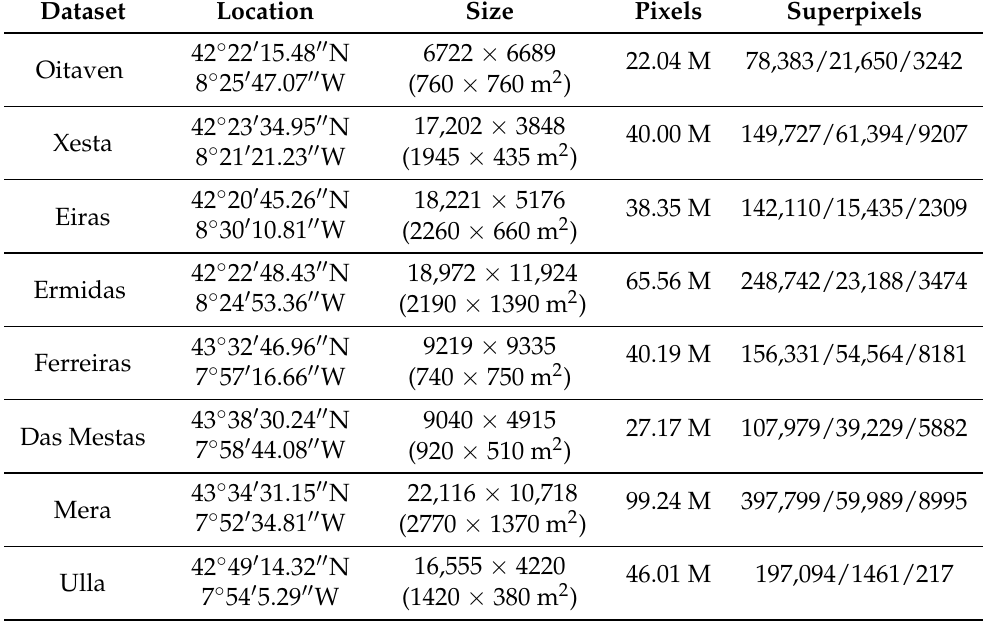
Table 1. Datasets used in this study. The column “Pixels” indicates the number of data values in the dataset, while the column “Superpixels” indicates the number of superpixels containing data values, those that are available in the reference data, and those used for